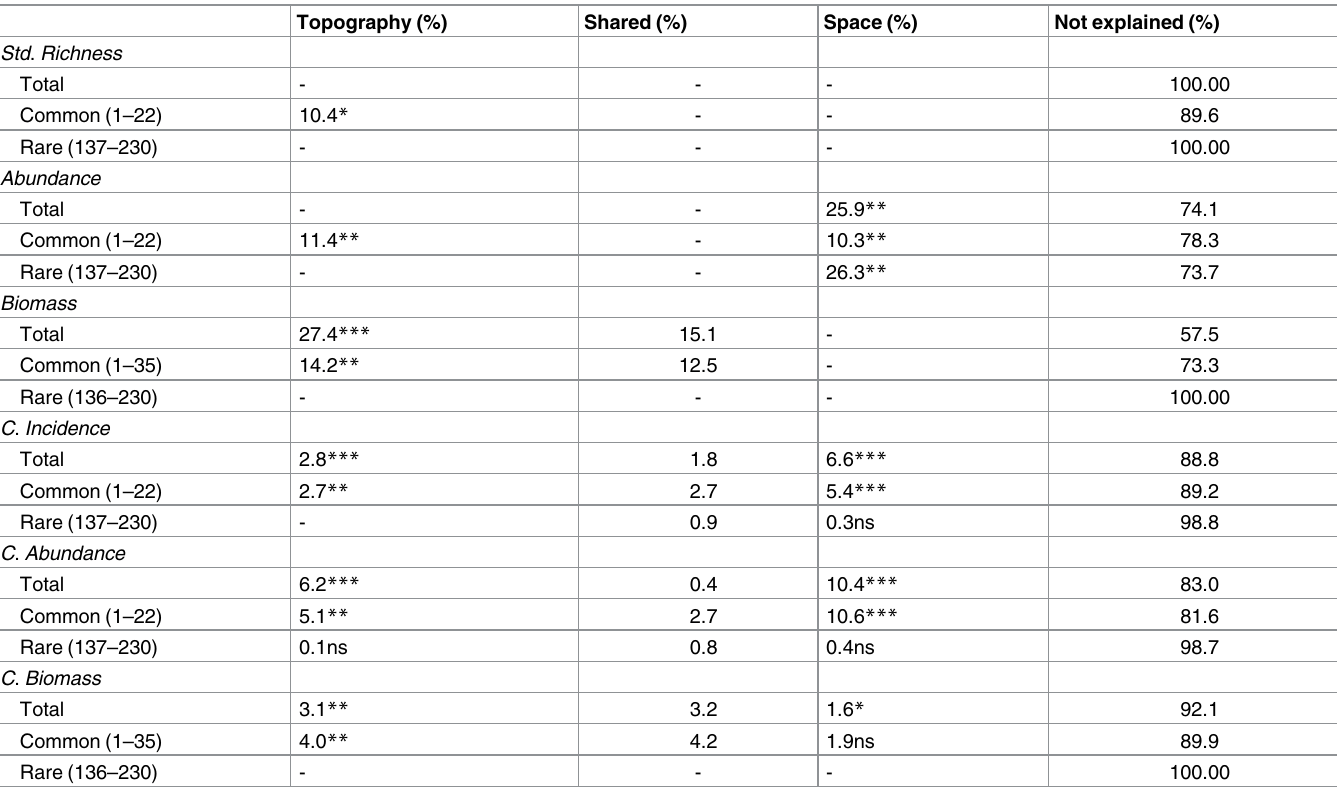
Table 2. Results of the partial multiple regression and partial RDA with the coefficient of determination (R 2 ) for whole community (total), common and rarespecies. Topography refers to the effects of geomorphometric variableswithout spatialcomponent,sharedrefers to the effects of common variation betweentopographicand spatial components, and space refers to the spatialeffects without topography. Common and rare species have the same informa- tion content and were delimitedbasedon the inflection point of the species x abundance curve (in the case of abundance)or species x biomasscurve (in the case of